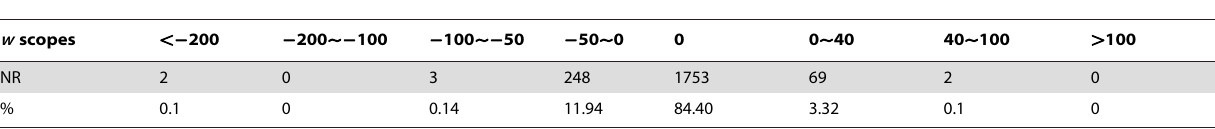
Table 2. w scopes, number of reactions (NR) and their percentages.